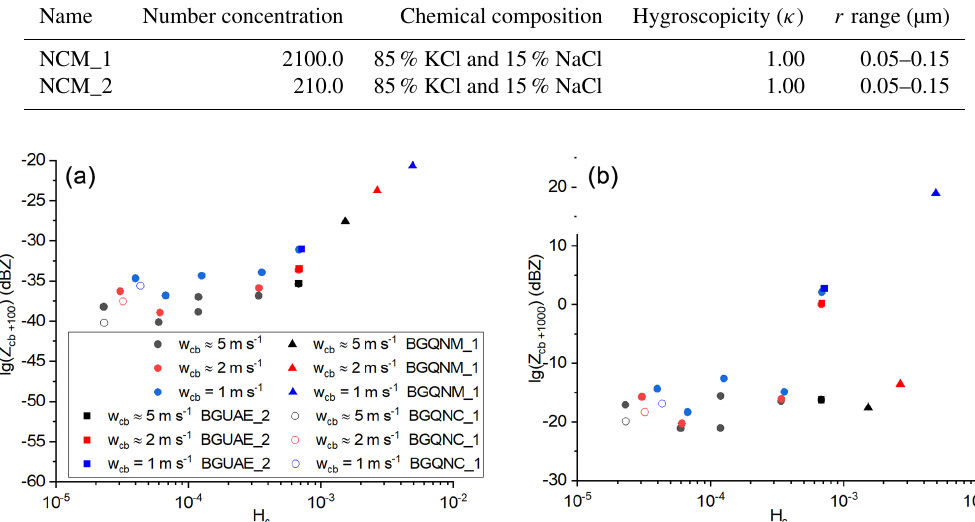
Table 4. Characteristics of the NCM aerosol particles. The unit of concentration is cm − 3 .